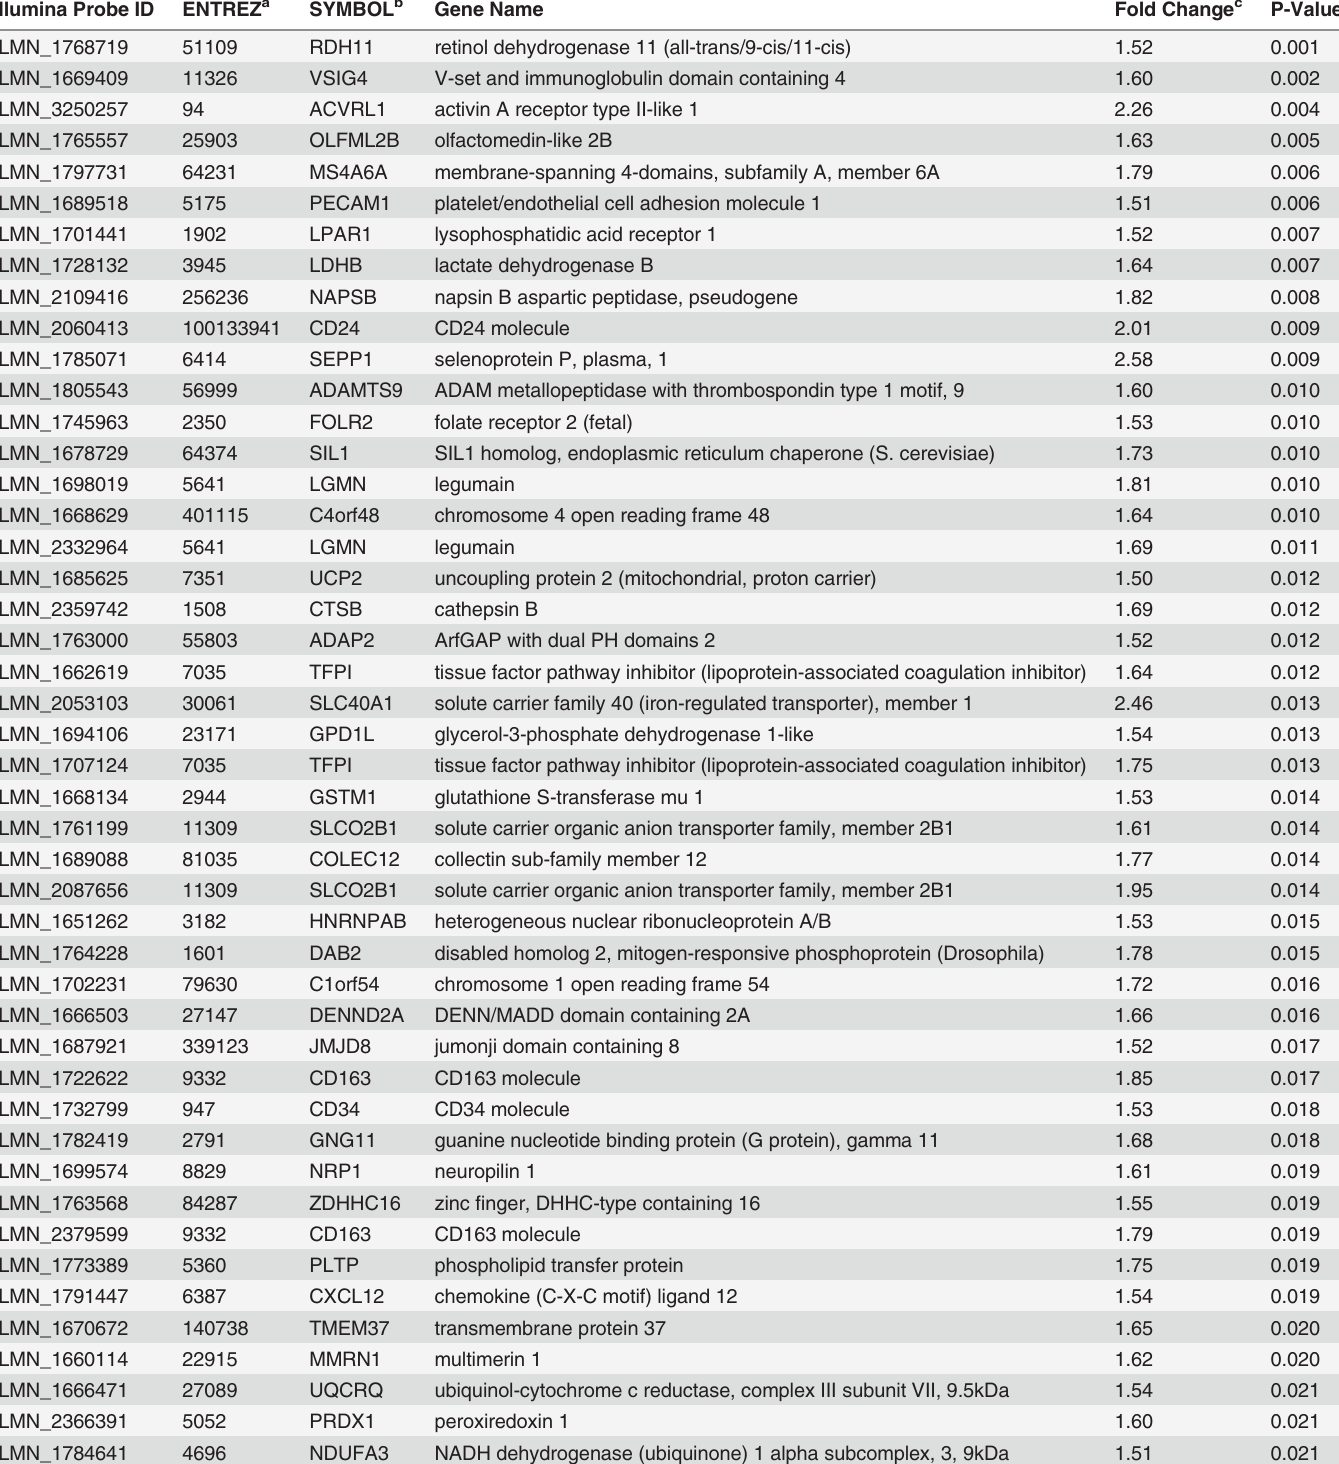
Table 3. Overexpressed Illumina probes (N = 105) in the neurocognitive impairment group compared to the no impairment group. Illumina Probe